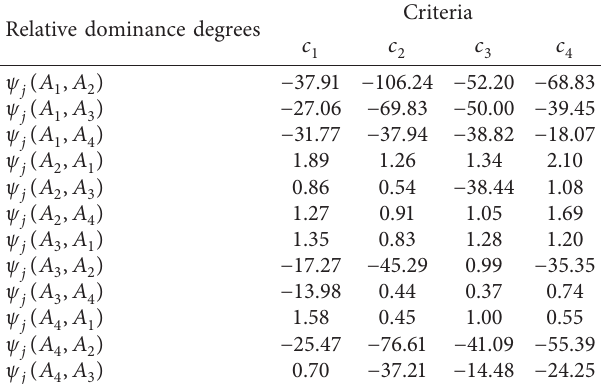
Table 12: Relative prospect dominance degrees.